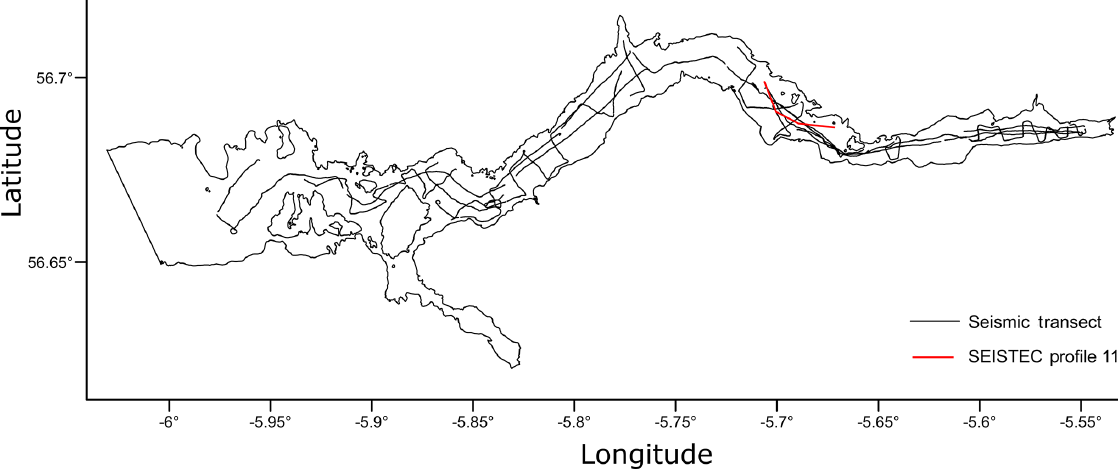
Figure 2. Map of the 34 seismic transects undertaken in Loch Sunart with SIESTEC profile 11